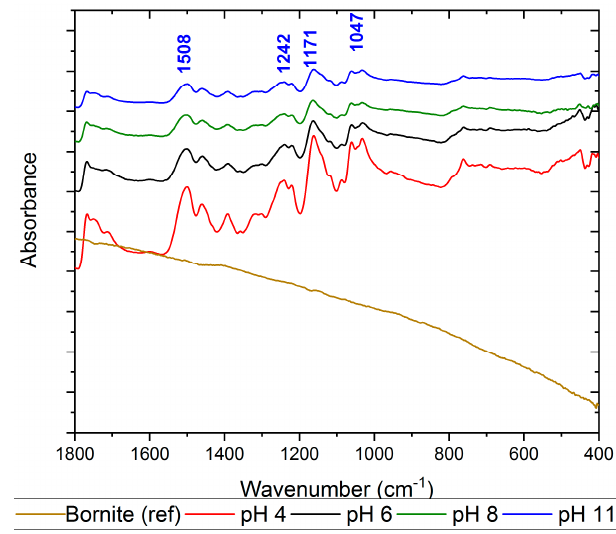
Figure 14. DRIFT spectra of thionocarbamate adsorption on bornite with increasing pH.